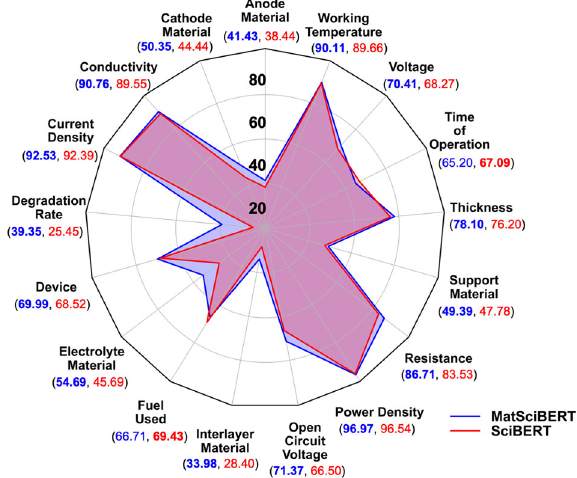
Fig. 2 Comparison of MatSciBERT and SciBERT on validation sets of SOFC-Slot dataset. The entity-level F1-score for MatSciBERT and Scibert models in blue and red color respectively. The bold colored text represents the best model ’ s score. Table 2. Macro-F1 scores on the test set for Matscholar averaged over three seeds.